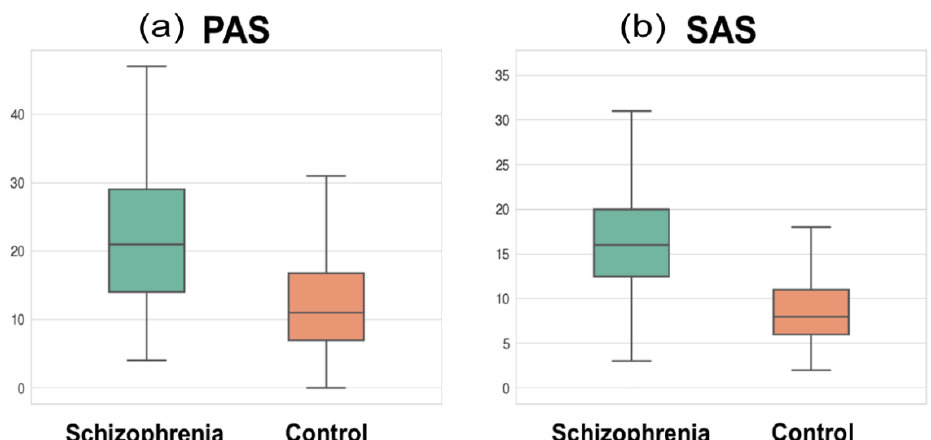
Figure 2. Box plot of ( a ) the physical anhedonia scale (PAS) and ( b ) social anhedonia scale (SAS) in the schizophrenia and control groups. The whiskers denote the farthest data from the box within the 1.5 inter-quartile range.